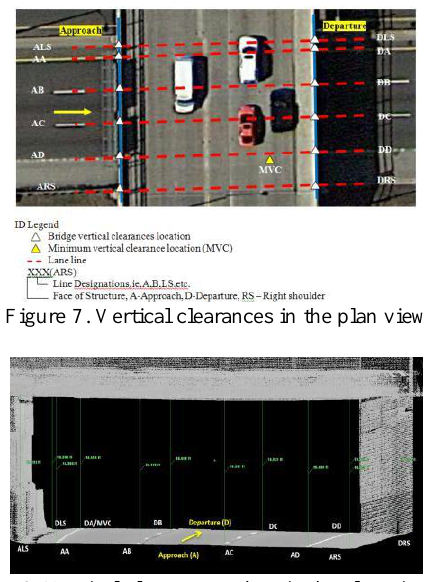
Figure 8. Vertical clearances taken in the elevation view